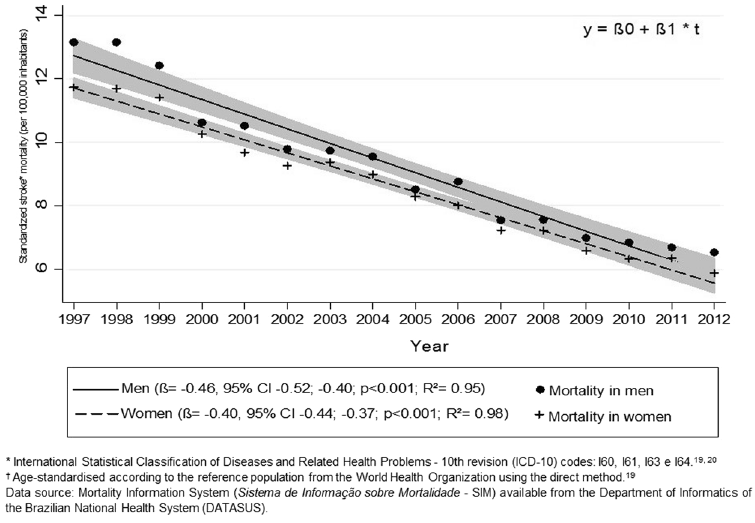
Figure 1. Proportional mortality related to stroke according to age† in Brazilian men and women.